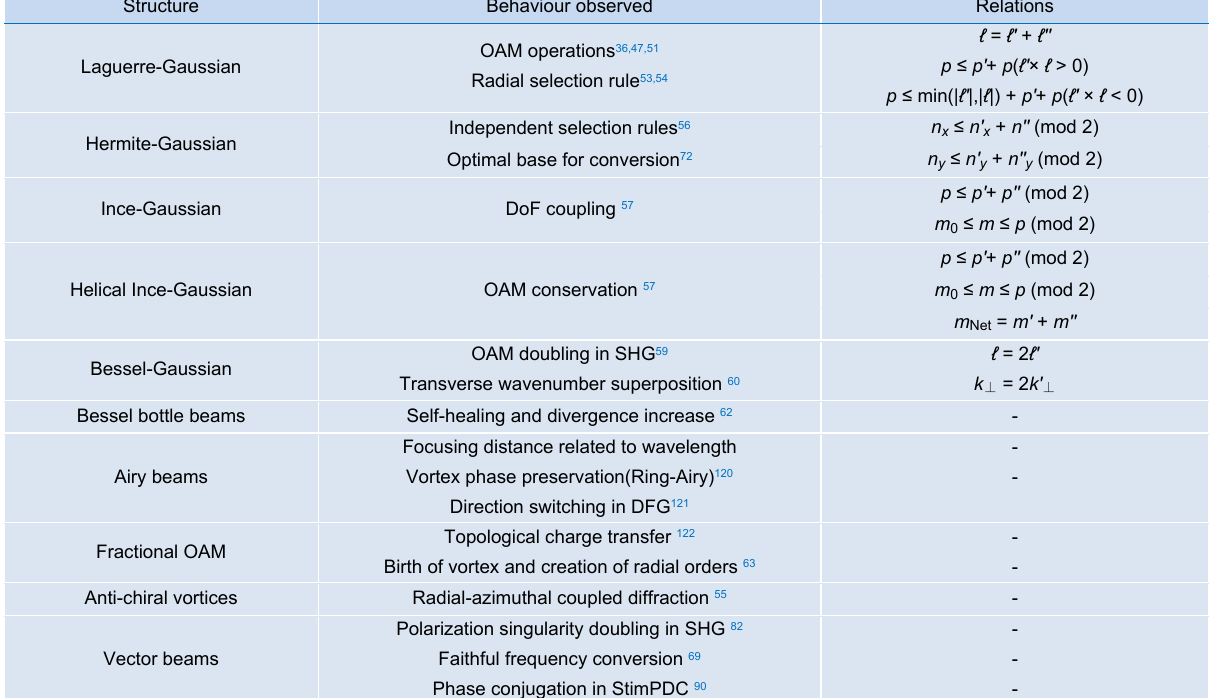
Table 1 | Behaviour of various structures of light in second order nonlinear wave mixing. Here, n x / n y are the indices for HG modes, ℓ , p are the azimuthal/radial indices for LG modes and p / m are the parameters for Ince-Gaussian modes. Indices with primes, such as ℓ′′ are of fundamental field modes and the ones without are of the frequency